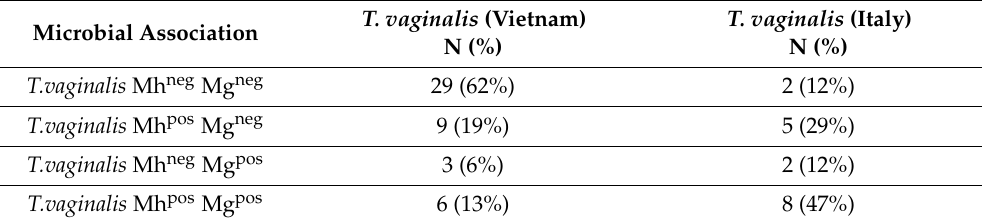
Table 1. The occurrence of M. hominis and Ca. M. girerdii among T. vaginalis strains isolated in Vietnam and Italy.